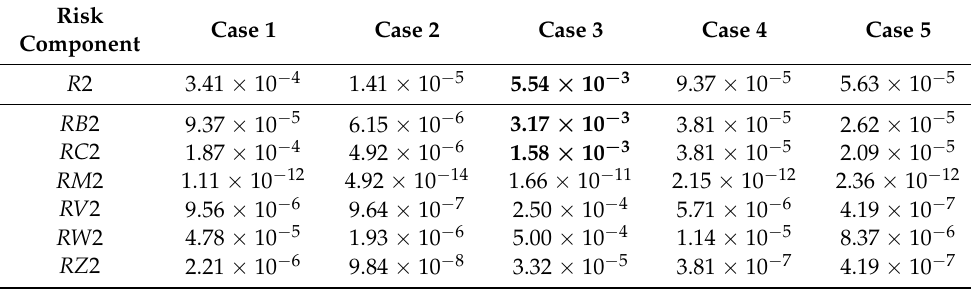
Table 22. Result of Risk Value of Loss of Service to the Public ( R 2) -Worse-case.